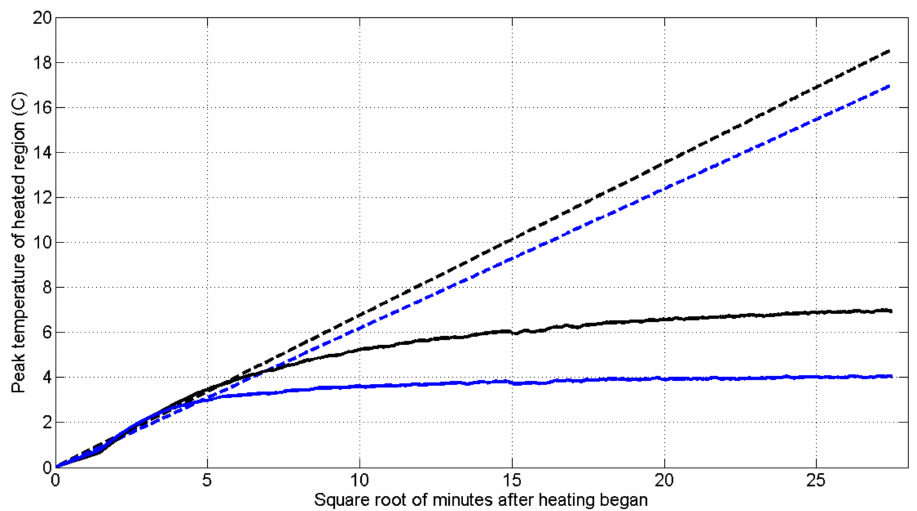
Figure 8. Demonstration for two locations of the diffusion (early time, plots as a straight-line versus square-root of time) versus advection (where the temperature reaches a steady-state where heat loss by advection is balanced by added energy) behavior as introduced in the context of Equations (1) and (2). These data were observed 333 m depth (blue lines) where the recorded temperature (solid line) diverged by 30% from the estimated heating for only conduction (dotted line) after approximately 50 min. At 620 m (black lines) it took approximately 160 min for that degree of divergence to occur, suggesting lower velocity lateral